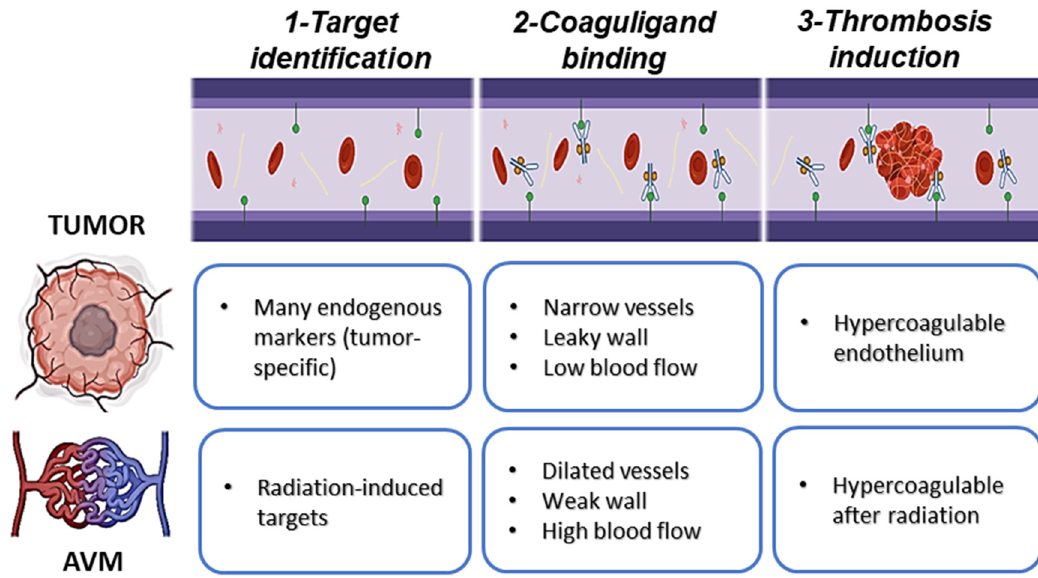
Figure 1. Vascular targeting with precision thrombosis in tumor and brain arteriovenous malformations (AVMs). Vascular targeting with precision thrombosis has potential for application in solid tumor destruction and occlusion of rupture-prone brain AVMs. In vascular targeting, a molecule uniquely expressed at the luminal surface of the diseased vasculature is identified as a target (1); a ligand (e.g., antibody, aptamer, peptide, or protein) with binding affinity for the target is attached to a thrombotic effector (e.g., thrombin, truncated tissue factor, or truncated staphylocoagulase) to form a “coaguligand” and delivered in the bloodstream (2); accumulation of the coaguligand at the target site in the presence of an inherent or induced hypercoagulable endothelial surface induces thrombus formation, leading to vessel occlusion (3). Adapting this approach for each pathology has its own challenges. Endogenously expressed surface markers which discriminate the endothelium of brain AVMs remain unknown. Stereotactic delivery of ionizing radiation to the AVM volume can be used to stimulate novel markers at the endothelial surface for both AVMs and tumor vasculature. Radiation also stimulates a procoagulatory surface in brain AVMs and enhances it in tumor vasculature. The large, dilated vessels in AVMs present extra challenges in the approach: high flow and shear stress may require high-affinity target-ligand interactions and effectors with greater thrombogenic potential. In tumor targeting, tumor cells at the rim may evade destruction. Vascular destruction is not required for AVMs however occlusion must be complete (all vessels stably thrombosed). [Original figure, created with BioRender.com by F. Faqihi].